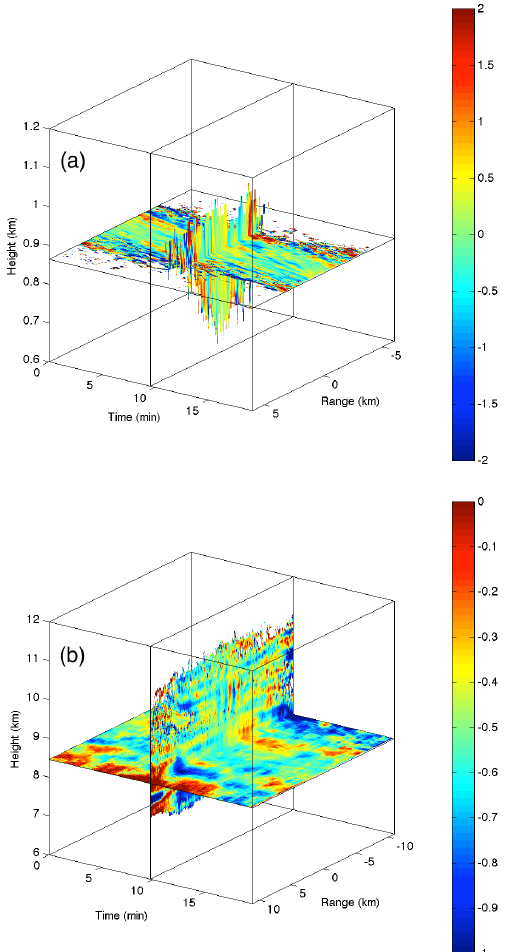
Fig. 13. 3-D representation of the retrieved vertical Doppler veloc- ities from a set of CW-RHI scans for (a) a stratocumulus case and (b) a cirrus case. The horizontal cross section is near the middle of the cloud layer and the vertical section half way through the